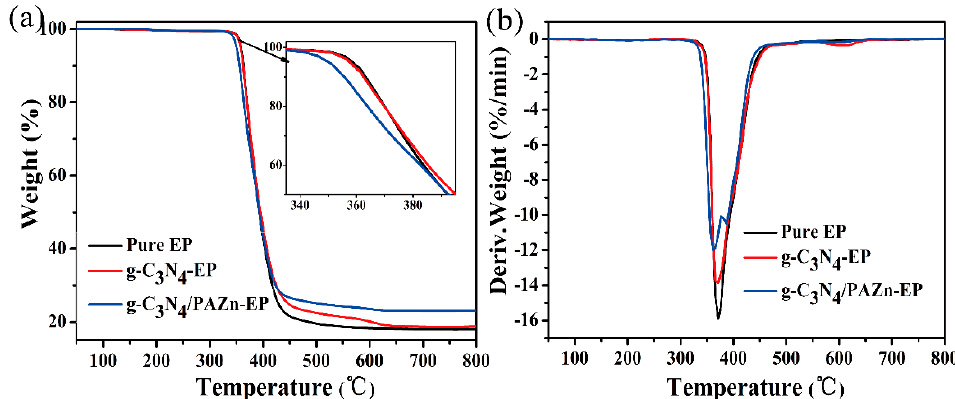
Figure 6. TGA ( a ) and DTG ( b ) curves of EP composites under N 2 atmosphere. Table 3. TGA and DTG data of EP composites.